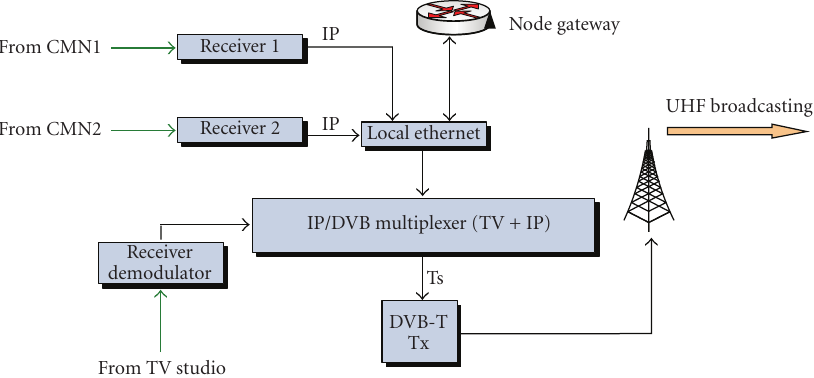
Figure 3: Configuration of regenerative